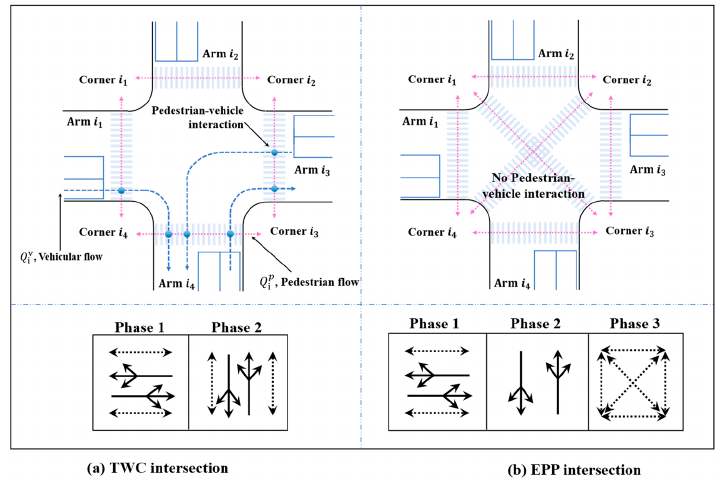
Figure 1. Intersection layout of under TWC and EPP phase patterns.